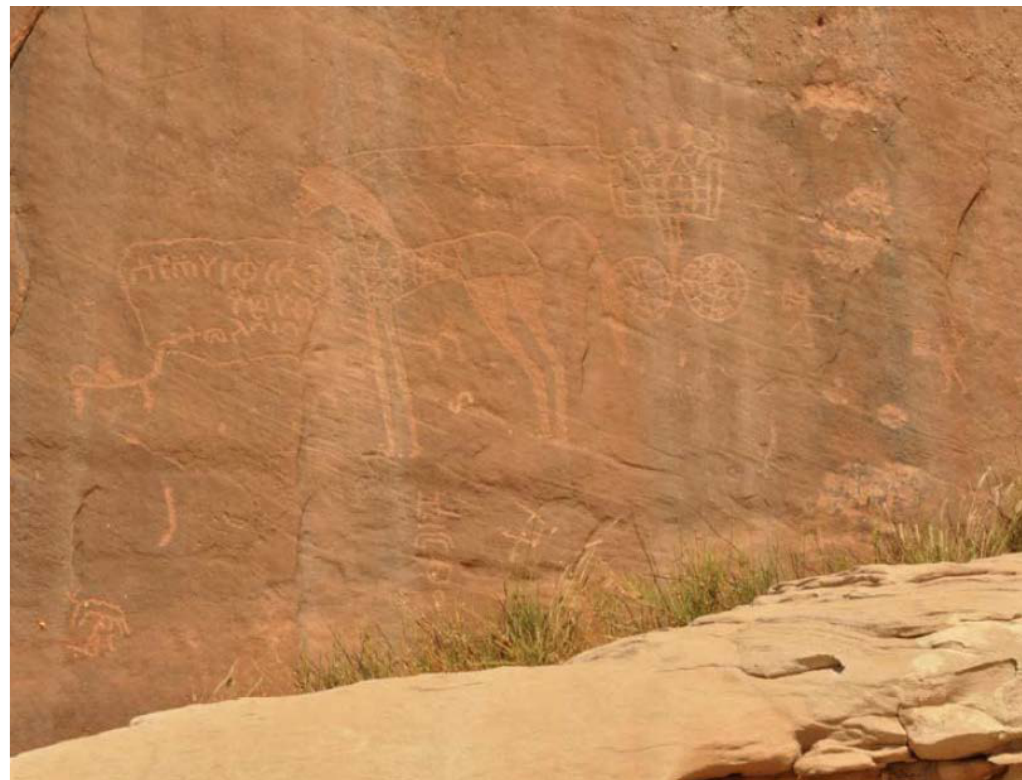
Figure 34. Chariot in Arabia associated with Thamudic inscription, perhaps indicating the names of the passengers. Located near Tayma, NW of the